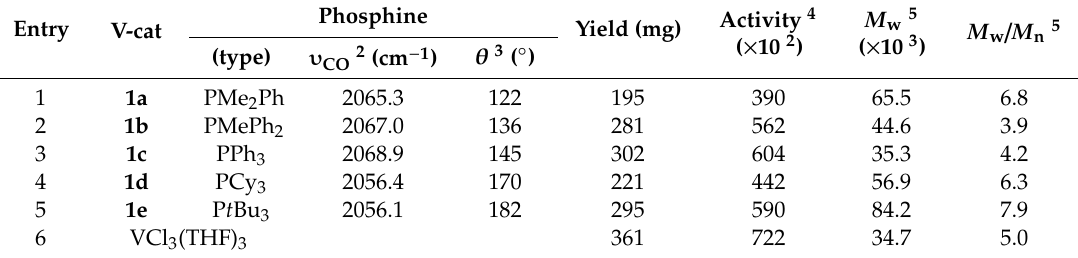
Table 1. Polymerization of ethylene catalyzed by 1a – 1e in combination with Et 2 AlCl. 1.